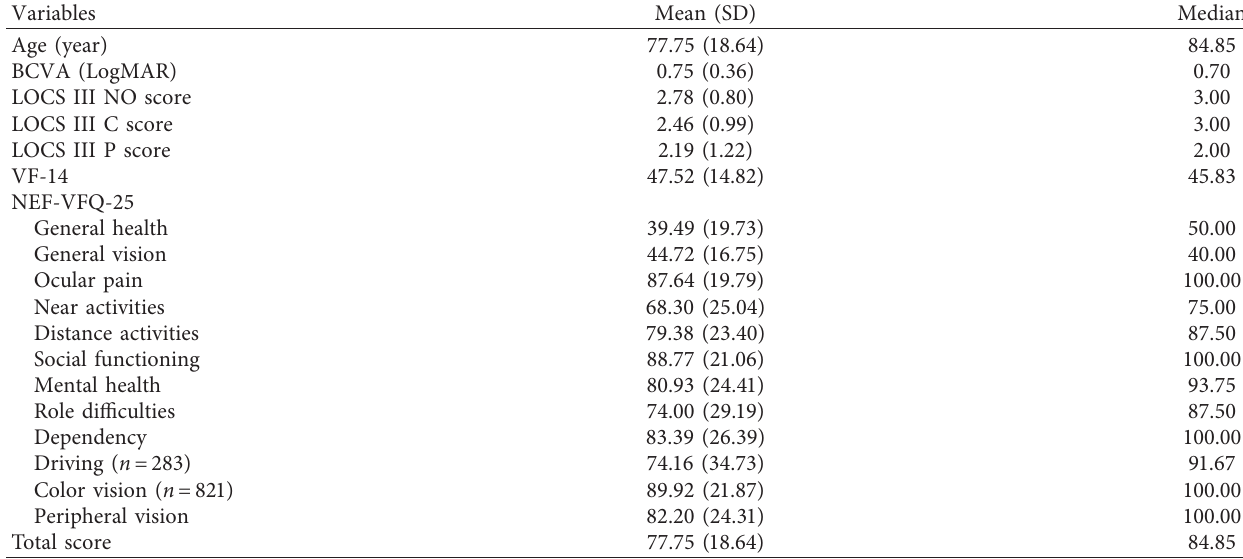
Table 1: Demographic and clinical characteristics, VF-14 score, and NEF-VFQ-25 scores of the participants ( n � 830).